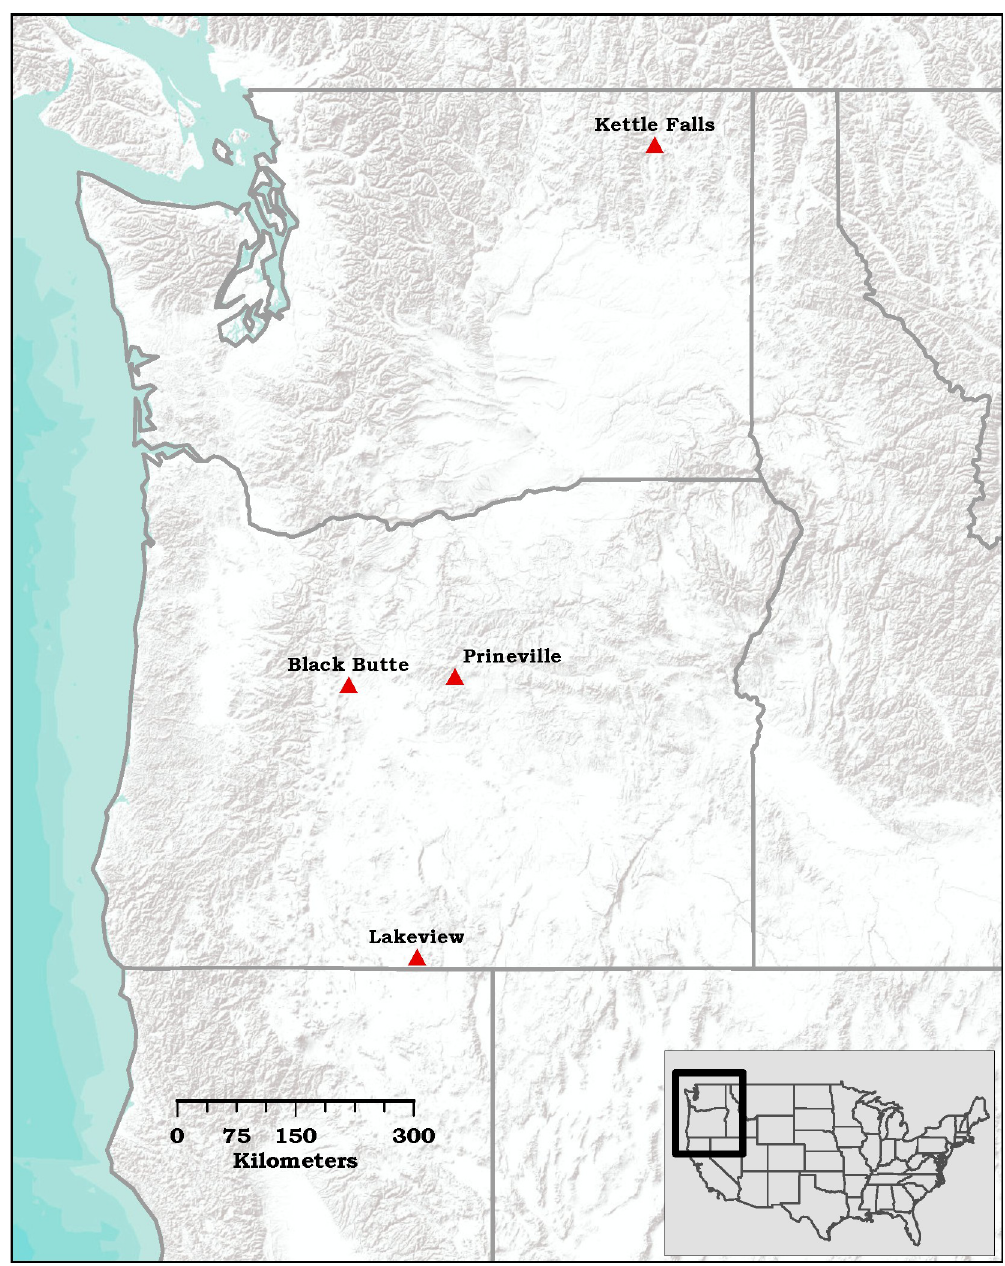
Fig 1. The four study site locations in Oregon and Washington,